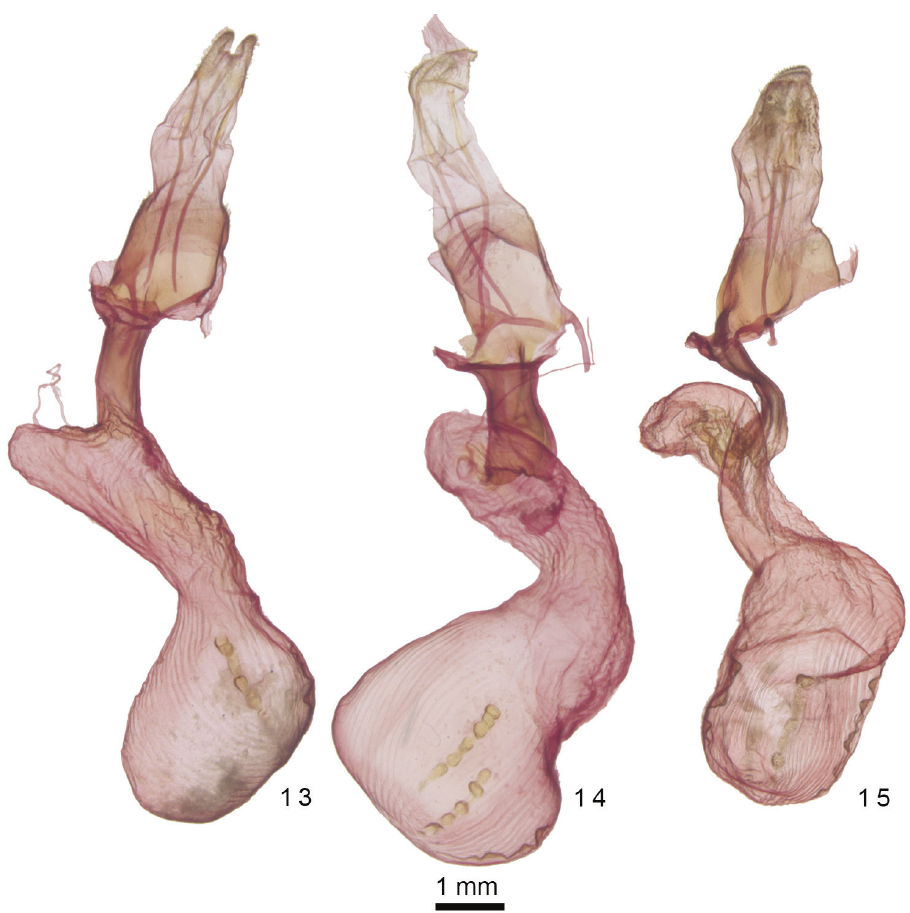
The barcode of A. similaris (BOLD:AAB7673) differs from both other Admetovis species by at least 3.5 %. Intraspecies variation is less than 0.9 % ( n = 19; Arizona, California,